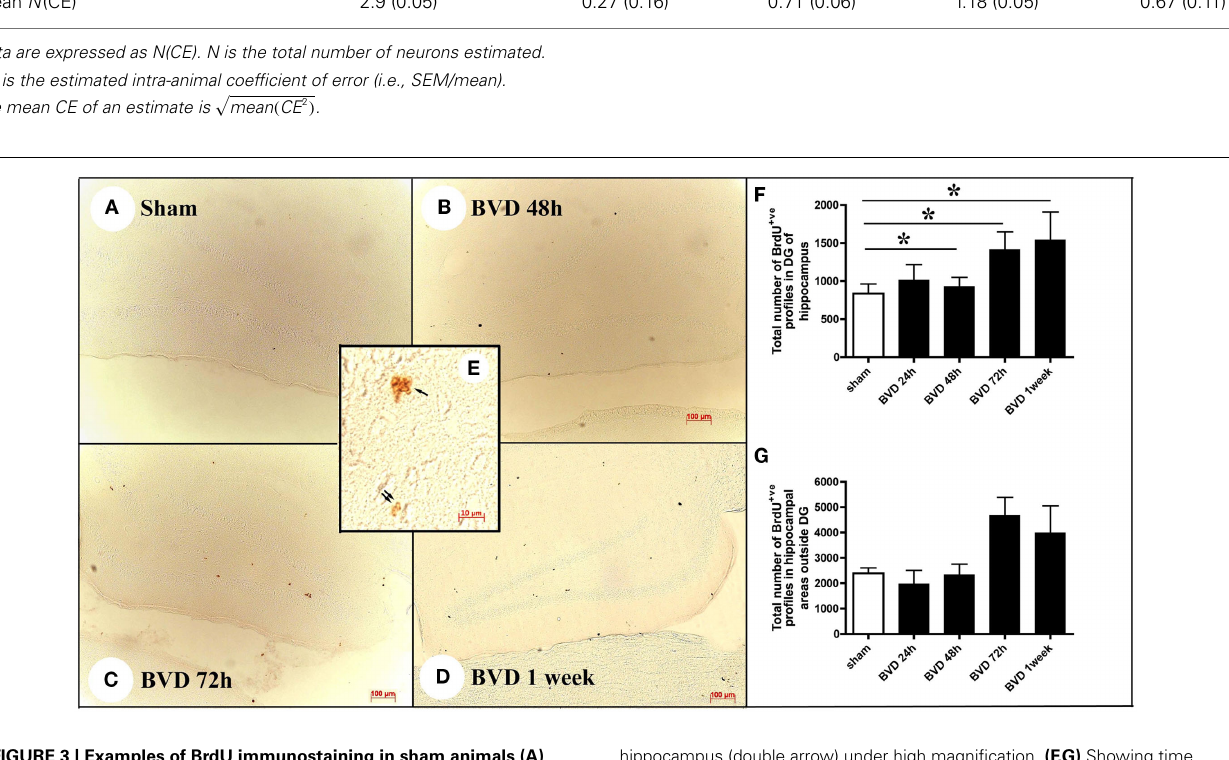
hippocampus (double arrow) under high magnification. (F,G) Showing time course changes in the total number of BrdU + nuclei estimated in the DG and other areas of the hippocampus, respectively. Data are expressed as mean ±